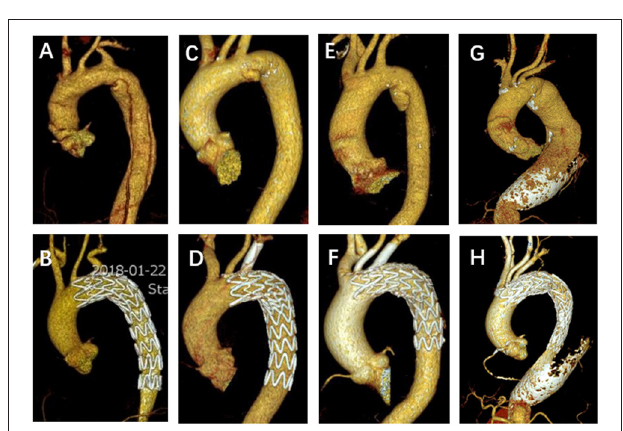
FIGURE 4 | Representative pictures of preoperative and follow-up CTA. (A,B) A non-bridging stent for LSA SF-TEVAR in a typical aortic dissection patient. (C,D) A single fenestration for LSA and one bridging stent implantation in a PAU patient. (E,F) Double-bridging stents for both LSA and LCA SF-TEVAR in a PAU patient. (G,H) A large fenestration for triple aortic arch branches without bridging stents in a case of arch and descending aortic aneurysm. CTA, computed tomography angiography; LSA, left subclavian artery; SF, self-radiopaque physician-modified fenestration; TEVAR, thoracic endovascular aortic repair; PAU, penetrating aortic ulcer; LCA, left carotid